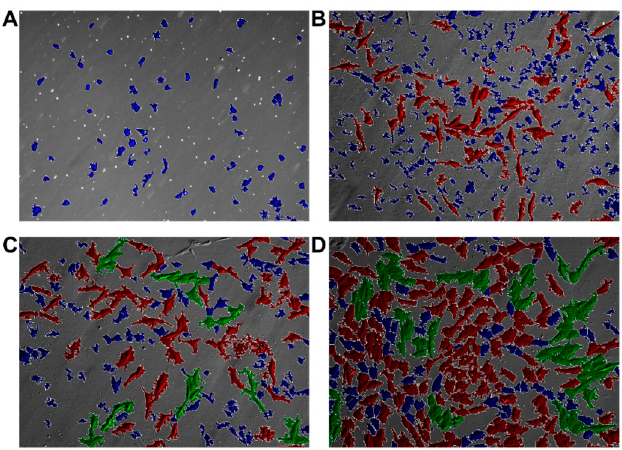
Figure 12. Segmentation outcomes for selected images acquired at, respectively, day 1 ( A ), 2 ( B ), 4 ( C ), and 7 ( D ) (10× resolution).